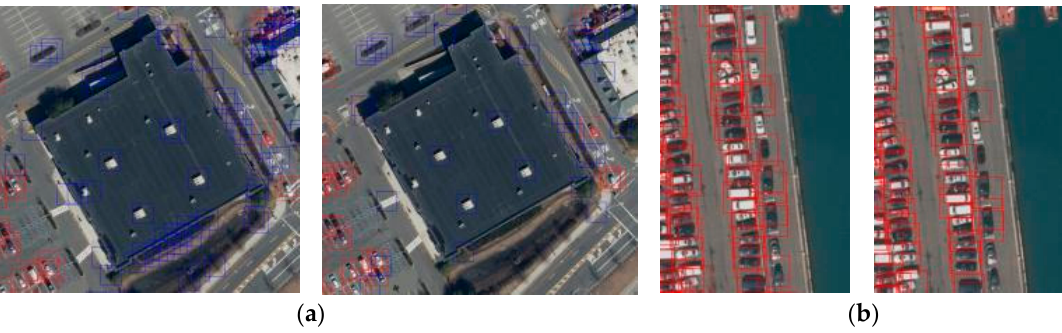
Figure 13. An example of good and bad cases in the tested images. In each pair of images, the left one shows the result of the normal method and the right one shows the result of HEM500. ( a ) Good case. On the right, FPs were much reduced; ( b ) bad case. On the right, some vehicles became undetected.